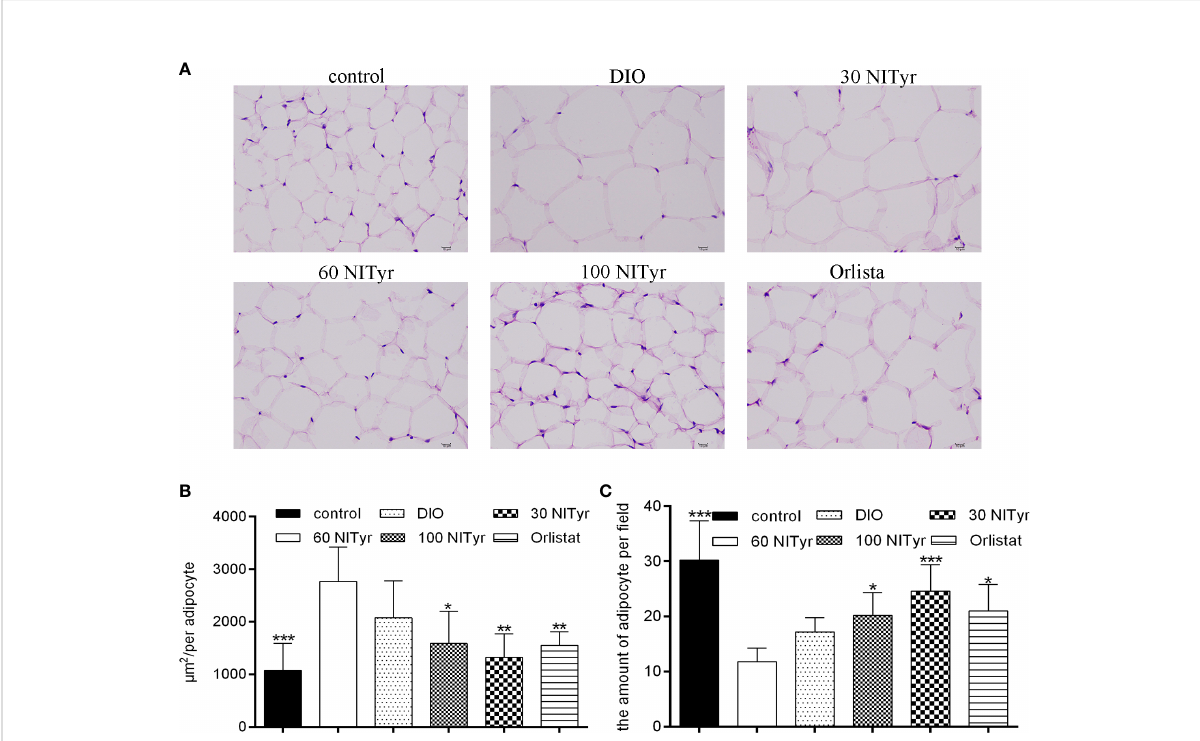
FIGURE 4 (A) The adipose tissue of mice stained by hematoxylin and eosin (H&E). scar bar = 10 µm. (B) The area of adipocytes in each group under the same fi eld. (C) the number of adipocytes in each group of mice under the same fi eld. The control or the DIO group was treated with Poloxamer 188 aqueous solution. 30 NITyr, 60 NITyr, 100 NITyr and Orlistat were treated with 30 mg/kg NITyr, 60 mg/kg NITyr, 100 mg/kg NITyr and 100 mg/kg Orlistat, respectively. All values were expressed as means ± SD. (n = 4). * P < 0.05, ** P < 0.01, *** P < 0.001, as compared with the DIO